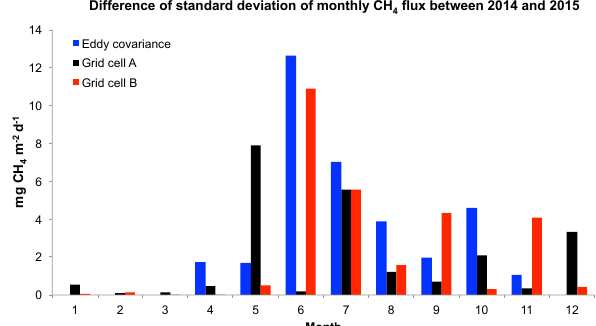
Figure 6. Comparison of the standard deviation of the monthly fluxes between 2014 and